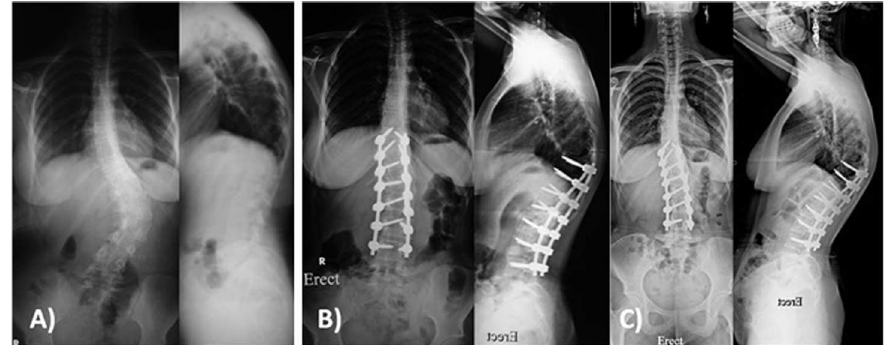
Figure 4. Female patient 17 years old with Lenke 5 c+. (A) Preoperative X-rays showing lumbar curve of 56 ° with thoracic kyphosis of 50 ° . (B) Postoperative X-rays showing posterior correction and fusion from T10-L4 with lumbar curve correction to 9 ° with thoracic kyphosis of 53 ° and radiological PJK. (C) Two years follow-up X-rays showing no progression of the PJK with preserved coronal